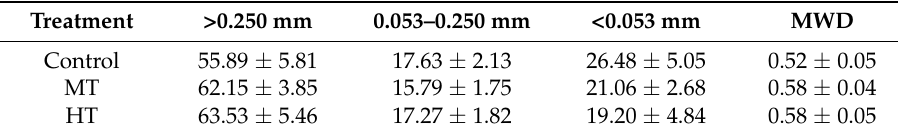
Table 2. Relative proportion of water-stable aggregates (WSA) and mean weight diameter (MWD) between the treatments in the 0–20 cm soil layer; Control: conventional management model, MT = moderate thinning, and HT = heavy thinning; n = 3, mean ±